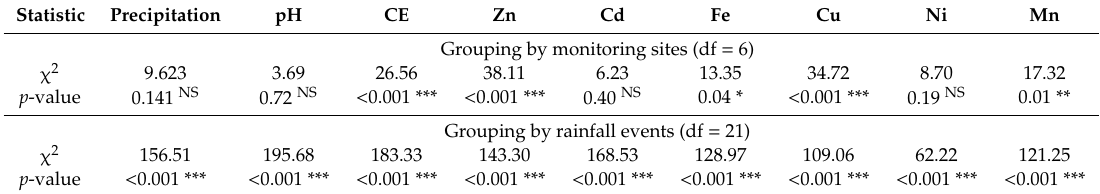
Table 2. Statistics of the Kruskal–Wallis analysis of variance between the monitoring sites and between rainfall